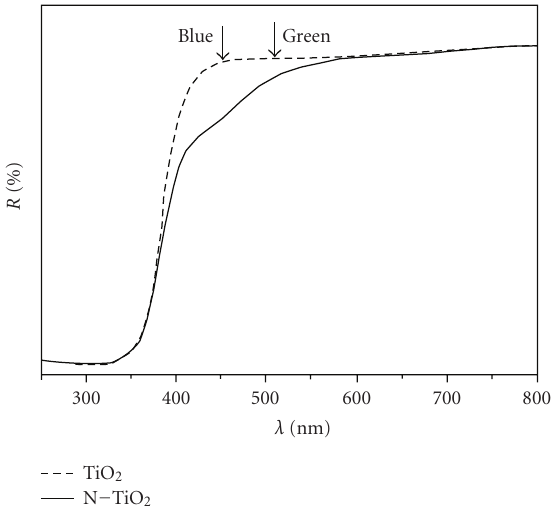
Figure 7: UV-visible di ff use reflectance spectra of undoped and N-doped TiO 2 . Reproduced with permission from [50]. Copyright (2006) American Chemical Society.